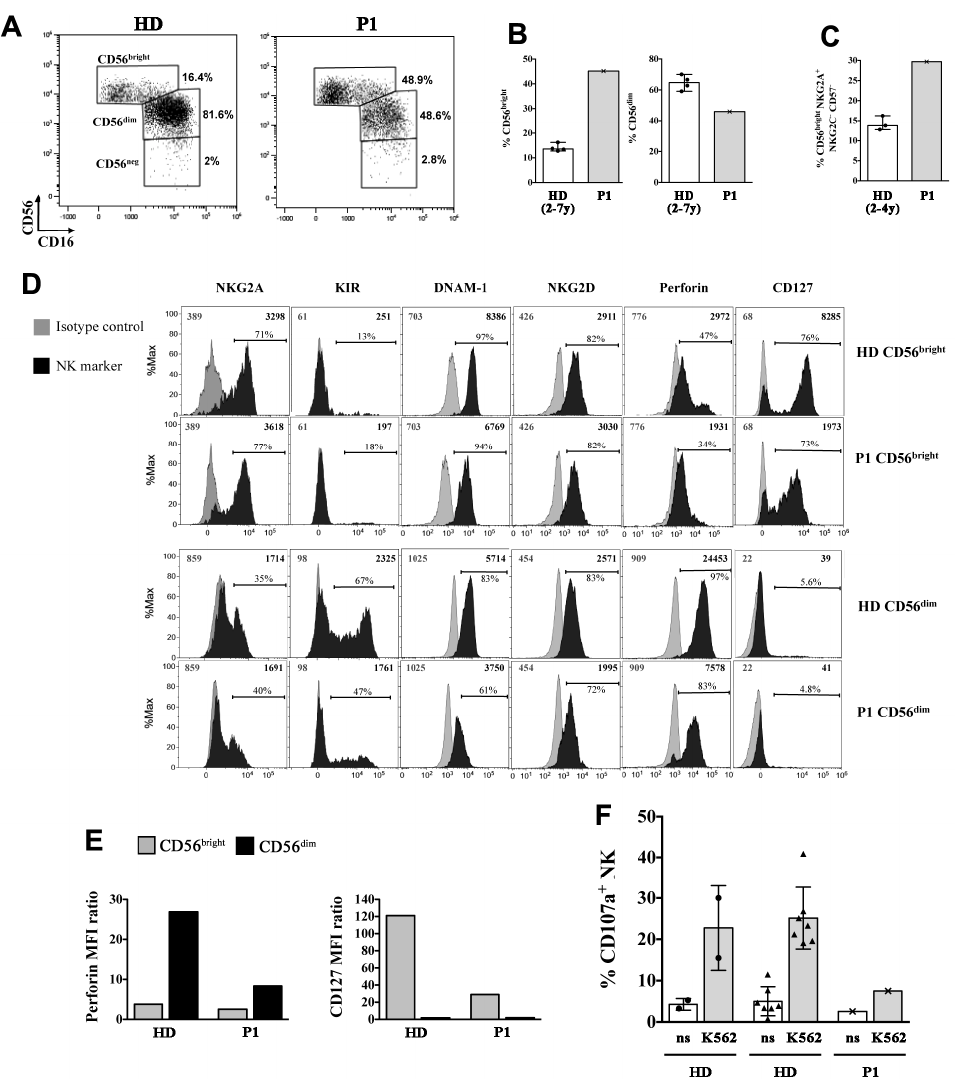
Figure 6. Phenotypic and functional alterations of NK cells in the P1 SIOD patient. ( A – C ) peripheral blood mononuclear cells (PBMCs) of P1 and of age-matched healthy donors (HDs) were analyzed by flow cytometry to measure the frequency of NK-cell subsets, the phenotype of gated CD56bright and CD56dim NK cells ( D , E ), and the NK-cell cytotoxicity ( F ). ( A ) The gating strategy used to identify CD56bright, CD56dim, and CD56neg NK cell subsets is shown for a representative HD and the SIOD patient, ( B ) Median and range of CD56 bright and CD56 dim cell frequencies among NK cells of the patient and four HDs is shown; ( C ) Median and range of CD56 bright cell percentage with a CD16-NKG2A+ NKG2C- CD57- immature phenotype among NK cells of P1 and three HDs is depicted, ( D ) Filled black histograms show the cell surface expression of NKG2A, KIR (KIRmix: KIR2DL1 / S1 / S3 / S5 and KIR2DL2 / L3 / S2), DNAM-1, NKG2D, and CD127 as well as intracellular perforin expression of gated CD56 bright and CD56 dim NK cells of P1 and a representative HD. Filled gray histograms represents staining with isotype control IgG. The mean fluorescence intensity (MFI) values for both NK marker labeling (black) and control IgG (gray), as well as the percentage of positive cells are indicated, ( E ) The values of perforin MFI (left) and CD127 MFI (right) divided by their control IgG MFI values (ratio) measured on CD56 bright and CD56 dim cells as shown in ( D ) are reported, ( F ) Bar plots represent pattern of CD107a expression measured by flow cytometry on gated NK cells of the patient and age-matched ( n = 2, circles) and adult ( n = 7, triangles) HDs following 6-h culture of PBMCs with and without (not stimulated, ns) K562 cell targets. The mean ± SD is